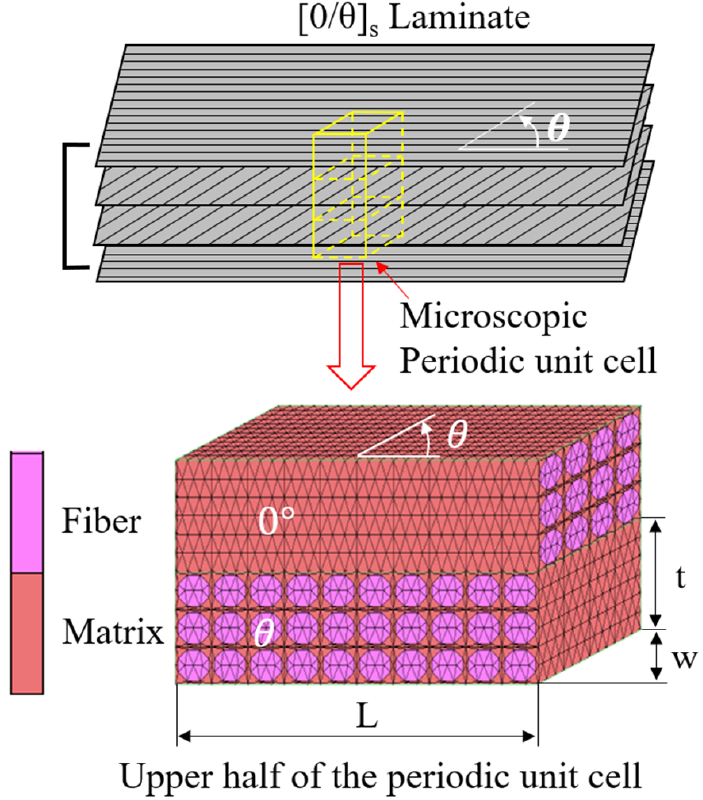
Figure 9. Periodic micromechanical model of a [0/ θ ] s laminate.